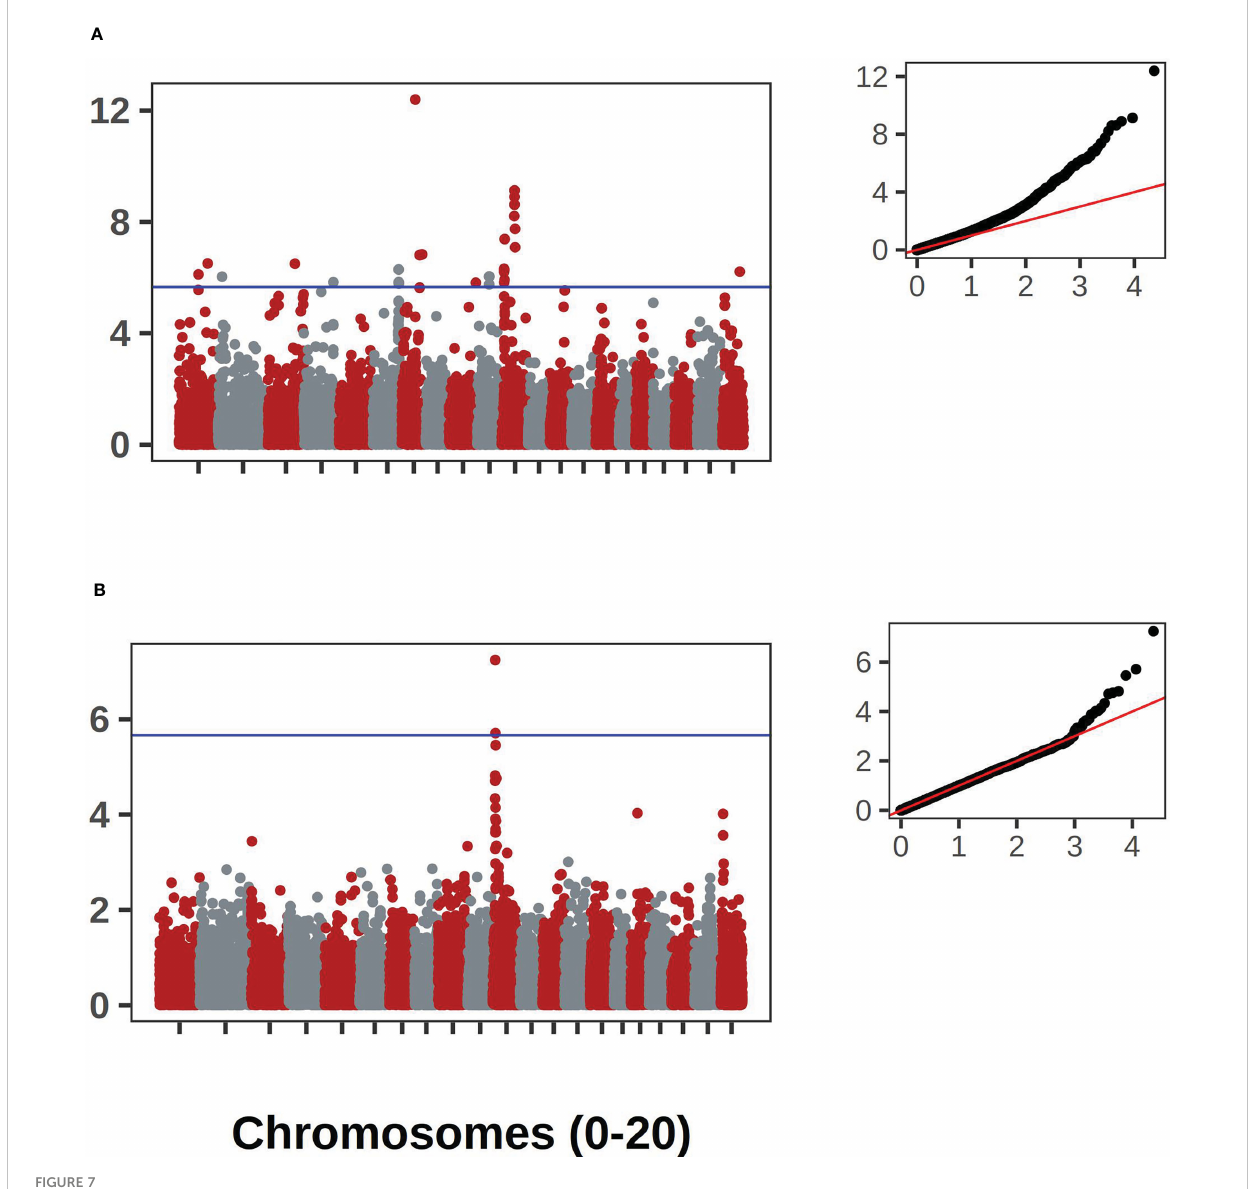
FIGURE 7 GWAS results for the Bu gene in C. pepo . (A) shows the association results using the historical data with accompanying Q-Q plot. (B) shows the results using the contemporary data set. Both analyses supported an association on chromosome